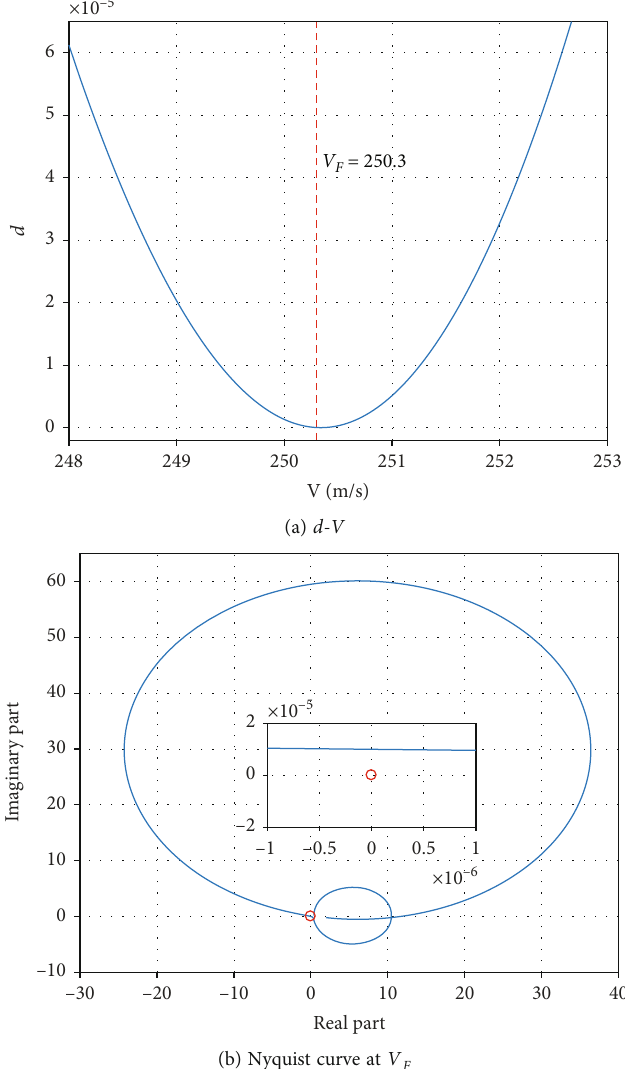
Figure 16: The unbiased GFBP curves of normal-state simulation model at Ma = 0 : 2